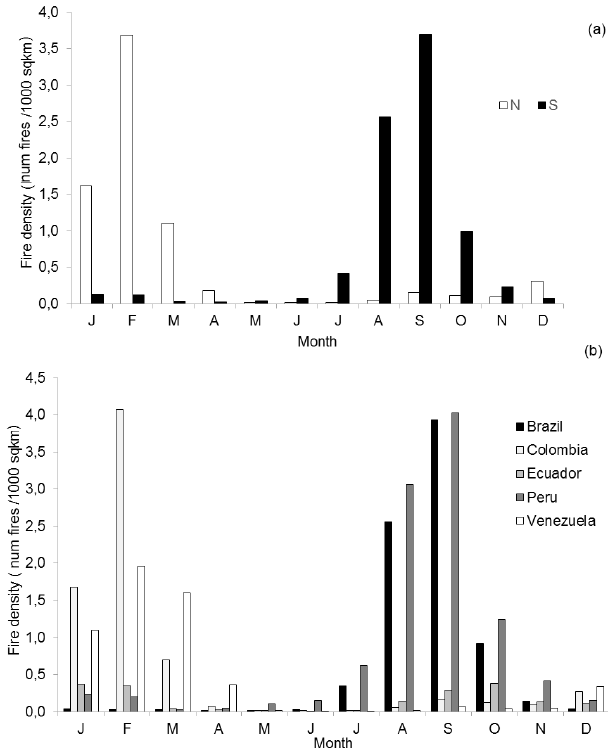
Figure 3. Monthly average satellite-detected active-fire density (number/1000sqkm) per latitudinal position (north, south) (a) and country (b)